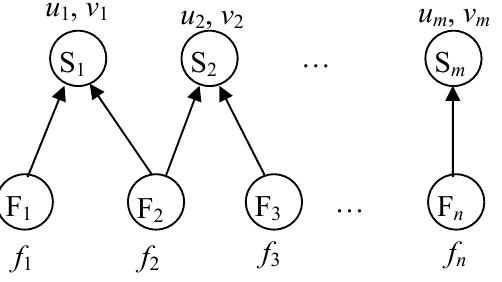
Figure 1. Bipartite graph to show the relations between faults and sensors.